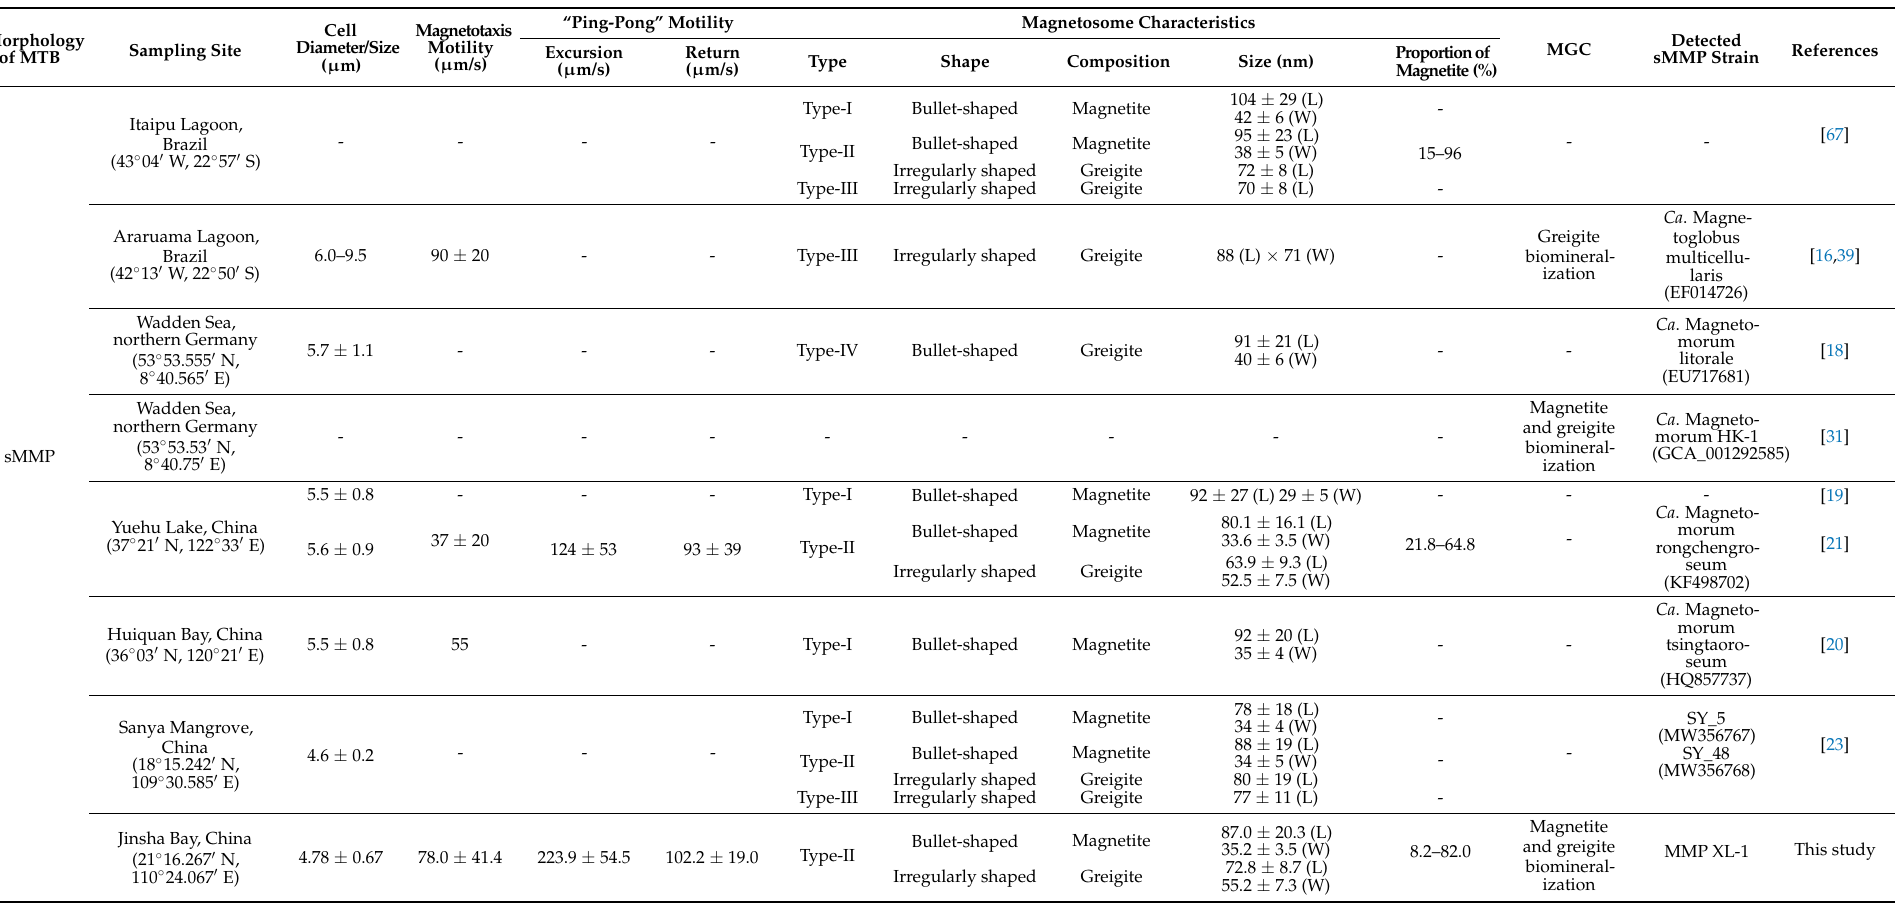
Table 2. Comparative characteristics of Deltaproteobacteria